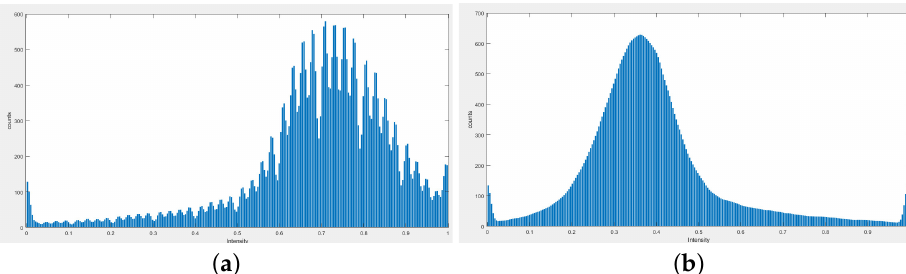
Figure 8. Comparison of Morphological operation Green channel Histogram and Homomorphic filtering Green channel Histogram. ( a ) Morphological operation Green channel Histogram ( b ) Homo- morphic filtering Green channel